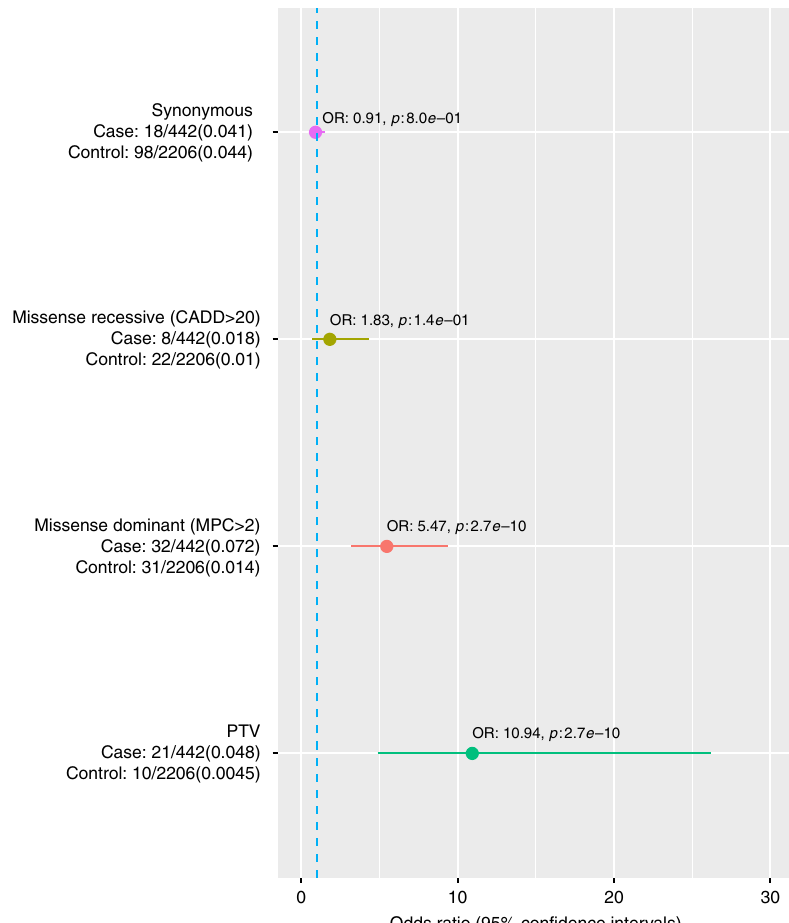
p : 5.9e − 5, Fisher ’ s exact test) were signi fi cantly enriched in cases (Fig. 3). The signal for PTV variants was almost exclusively in genes intolerant of PTV-mutations (pLI < 0.95, OR: 1.16, 95% CI: 0.94 – 1.44, 1.7e − 1; Fig. 3). Homozygous PTVs (likely complete